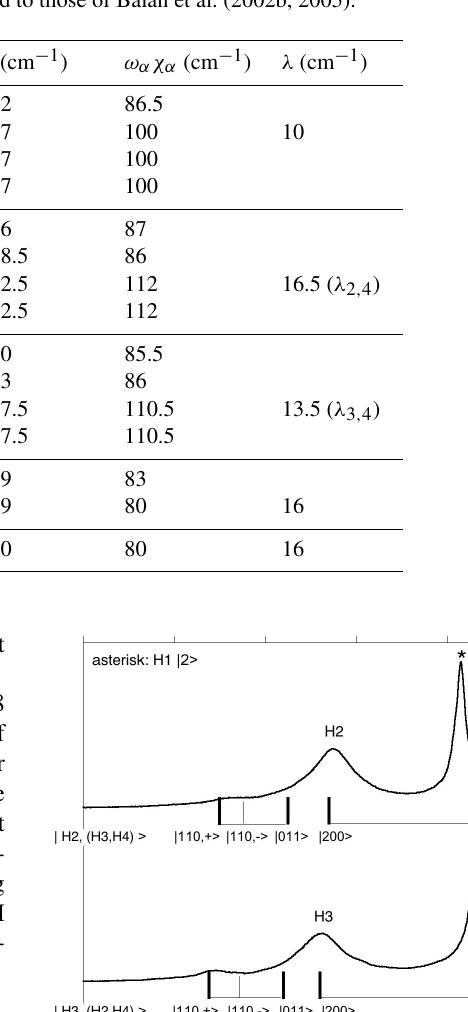
Table 2. Effective parameters of local OH-stretching modes in 1 : 1 phyllosilicates: harmonic frequencies ω α , anharmonicity constants ω α χ α and mode coupling parameters λ . The labels of H atoms correspond to those of Balan et al. (2002b, 2005).